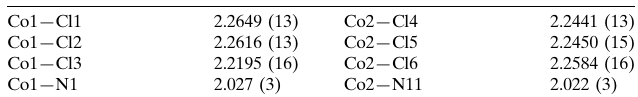
Selected bond lengths (A˚ ).